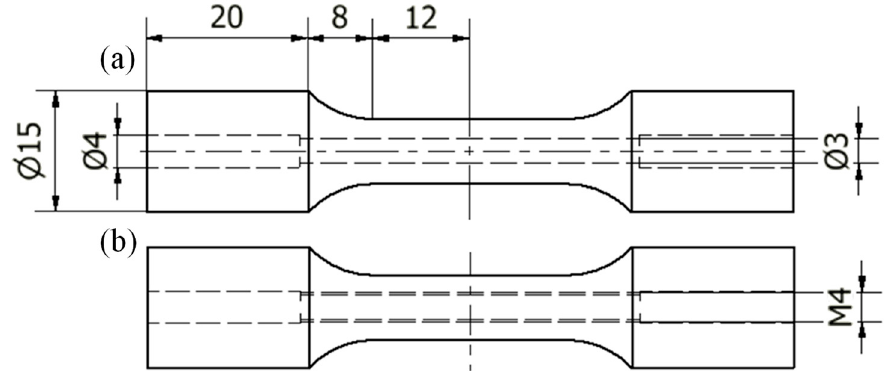
Figure 2. Geometry and dimensions of the holed specimens. ( a ) drilled specimens and ( b ) threaded specimens (M4 × 0.7)